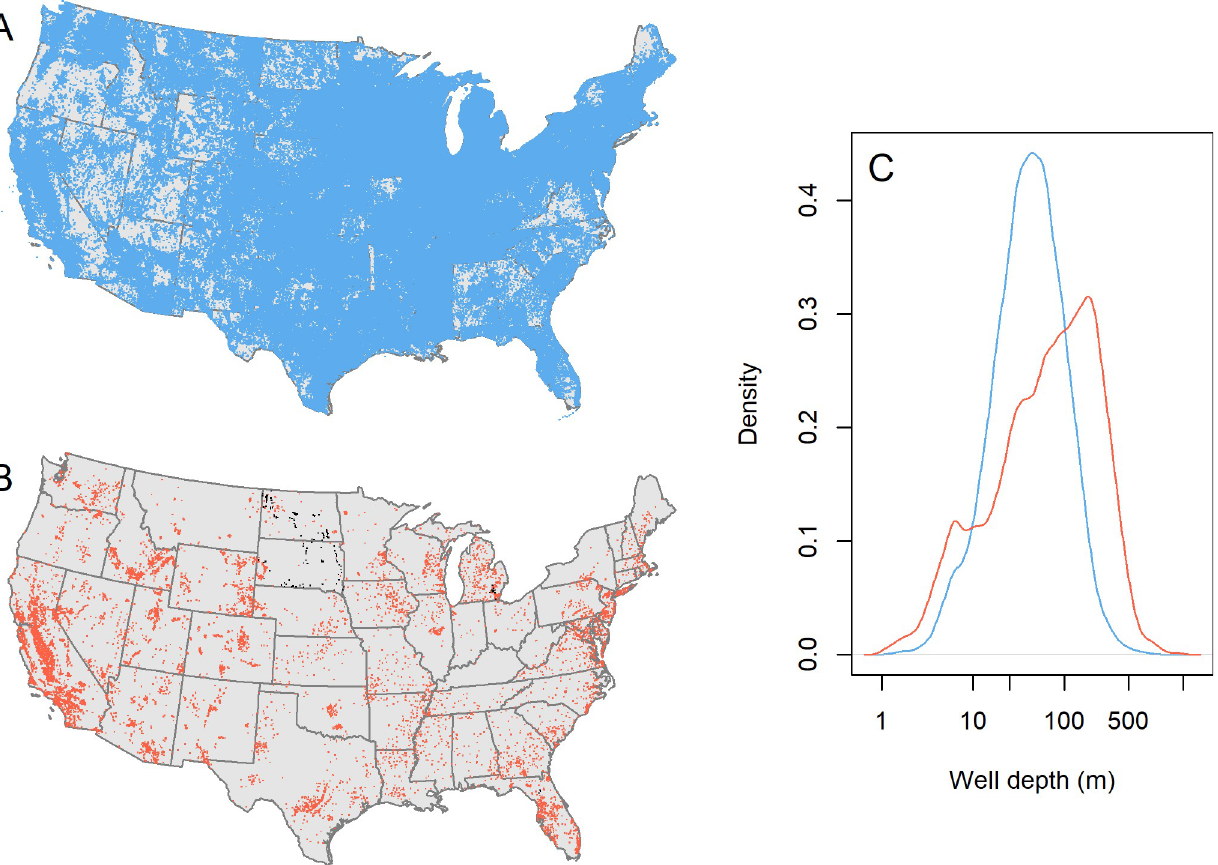
Fig 1. Properties of the GWD and GWI datasets. (A) Spatial distribution of GWD records. (B) Spatial distribution of GWI records. Black points represent new data produced for this study, all other data were compiled from other sources. (C) Distribution of well depths in the GWD (blue) and GWI (red)